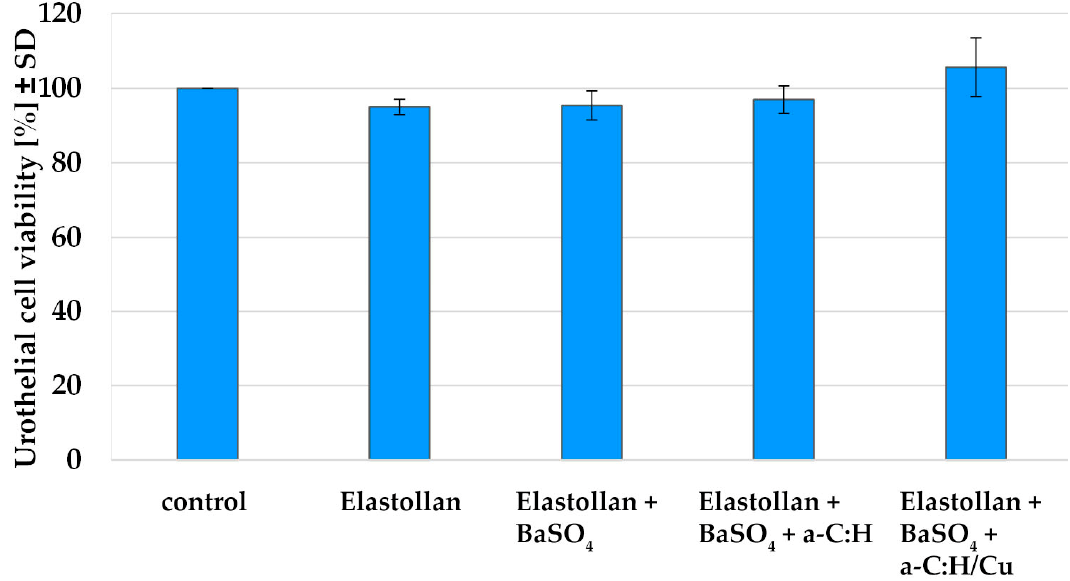
Figure 2. Cell viability after 24 h incubation with the different materials +/ − coating. Regardless of the addition of barium sulphate, or the coating with a-C:H or a-C:H/Cu-mulitilayer, the excellent biocompatibility of the material is maintained ( n = 3).